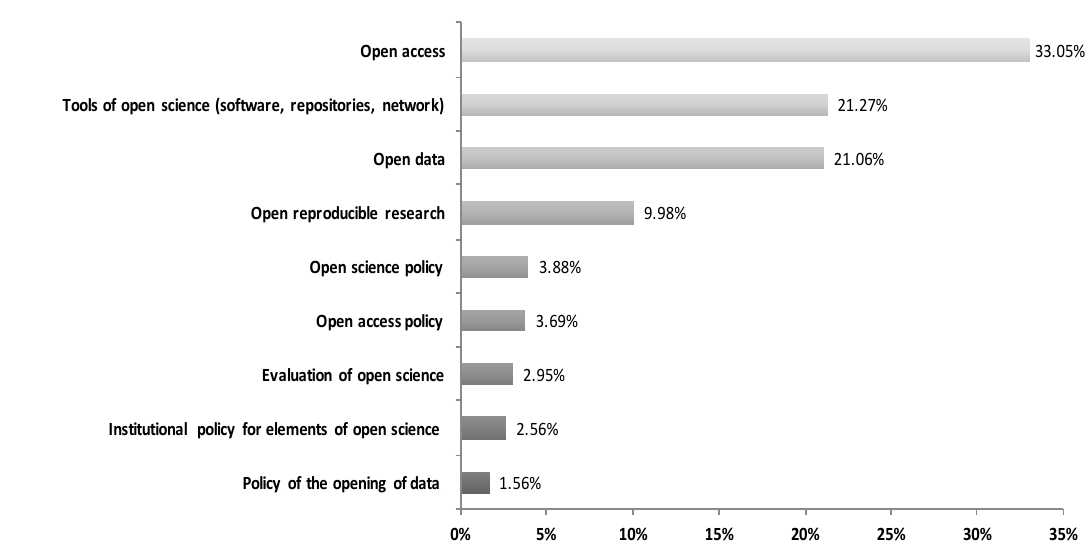
Figure 3. Elements of open science most used by Colombian researchers.